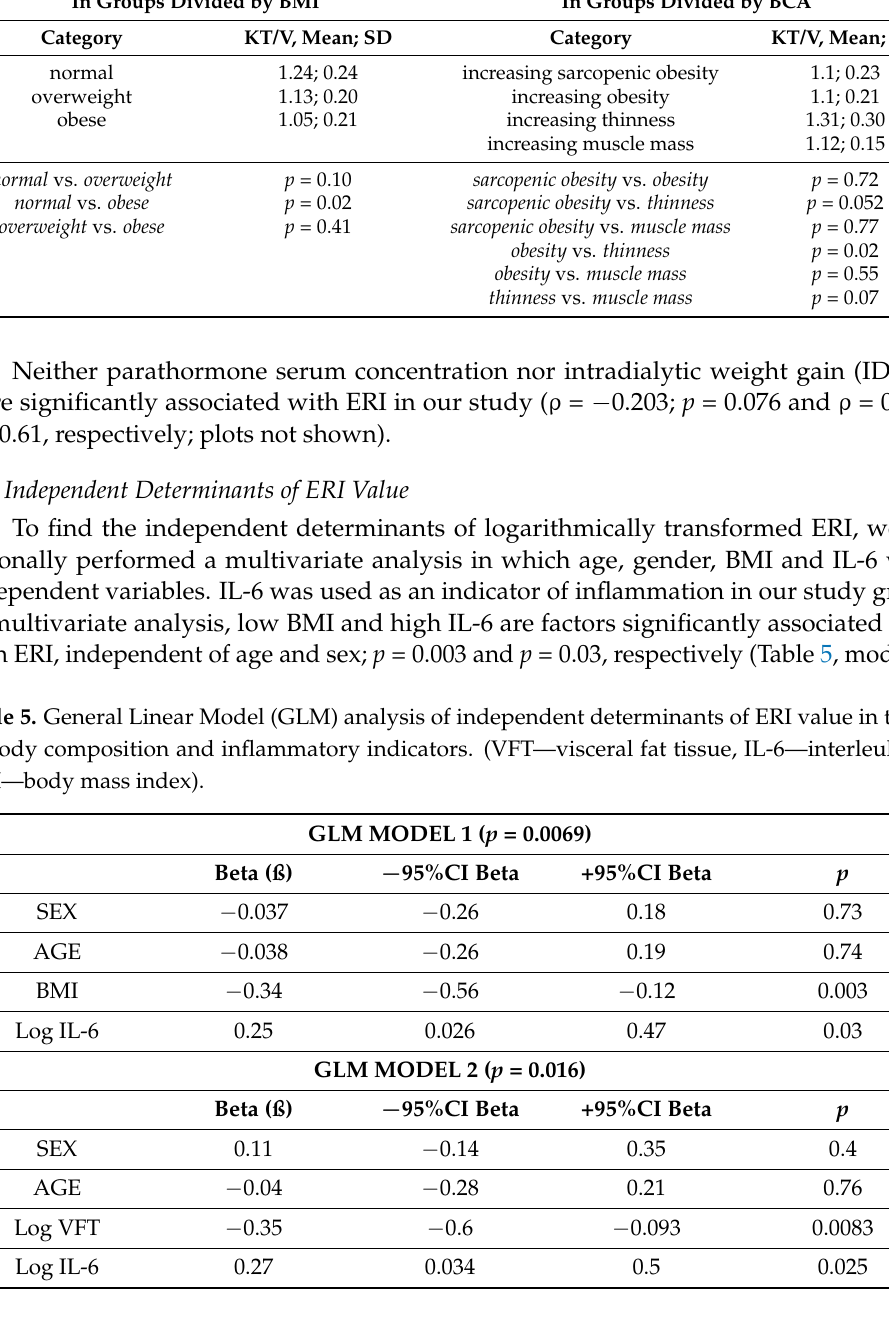
Table 4. Kt/V and nutrition as determined by BMI and body composition analysis. KT/V and Nutrition Comparison between Groups (U-Mann-Whitney Test)